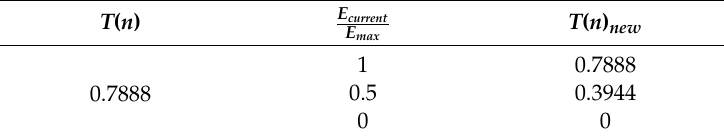
Table 1. Change in the selection probability for being CH due to residual energy.